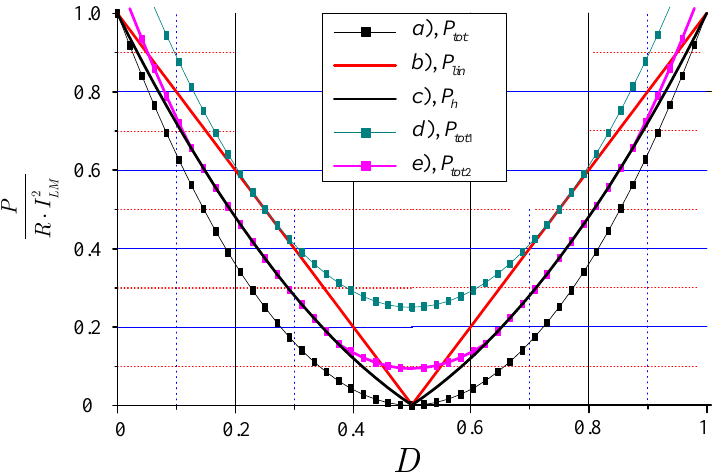
Figure 3. Normalized power consumption as a function of D , for several amplifier realizations: ( a ) HB with bilateral power supply, Equation (8); ( b ) Class-AB power amplifier, Equation (9); ( c ) HB with unilateral power supply and ideal absorption of negative supply currents, Equation (10); ( d ) P tot1 Equation (19); ( e ) P tot2 Equation (20).